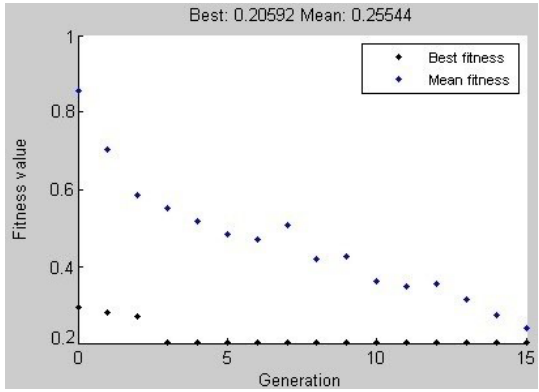
Figure 3. A fitness function plot to obtain the best configuration sensors on the nonuniform wind turbine tower.